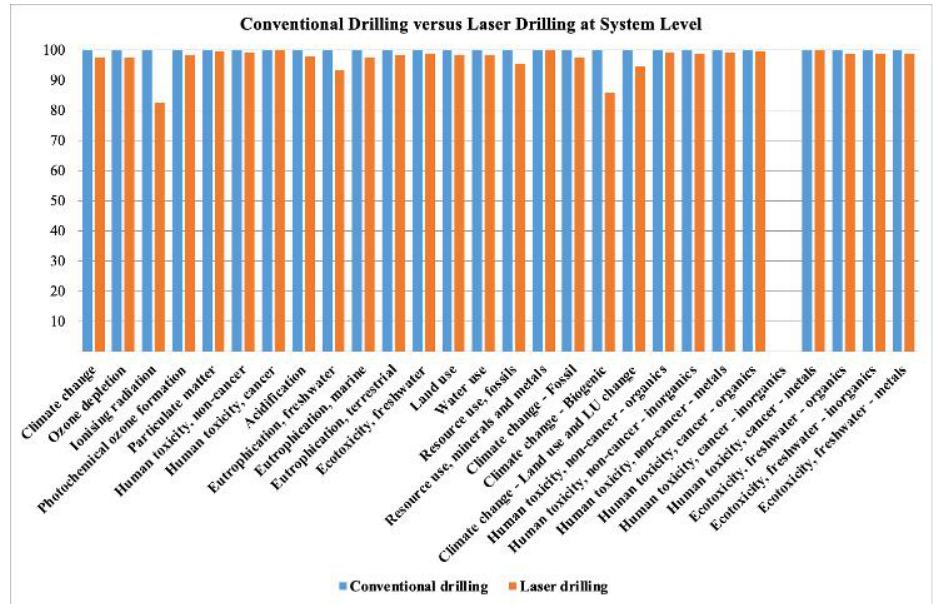
Figure 5. Comparison of the environmental impact of conventional and laser drilling at system level.